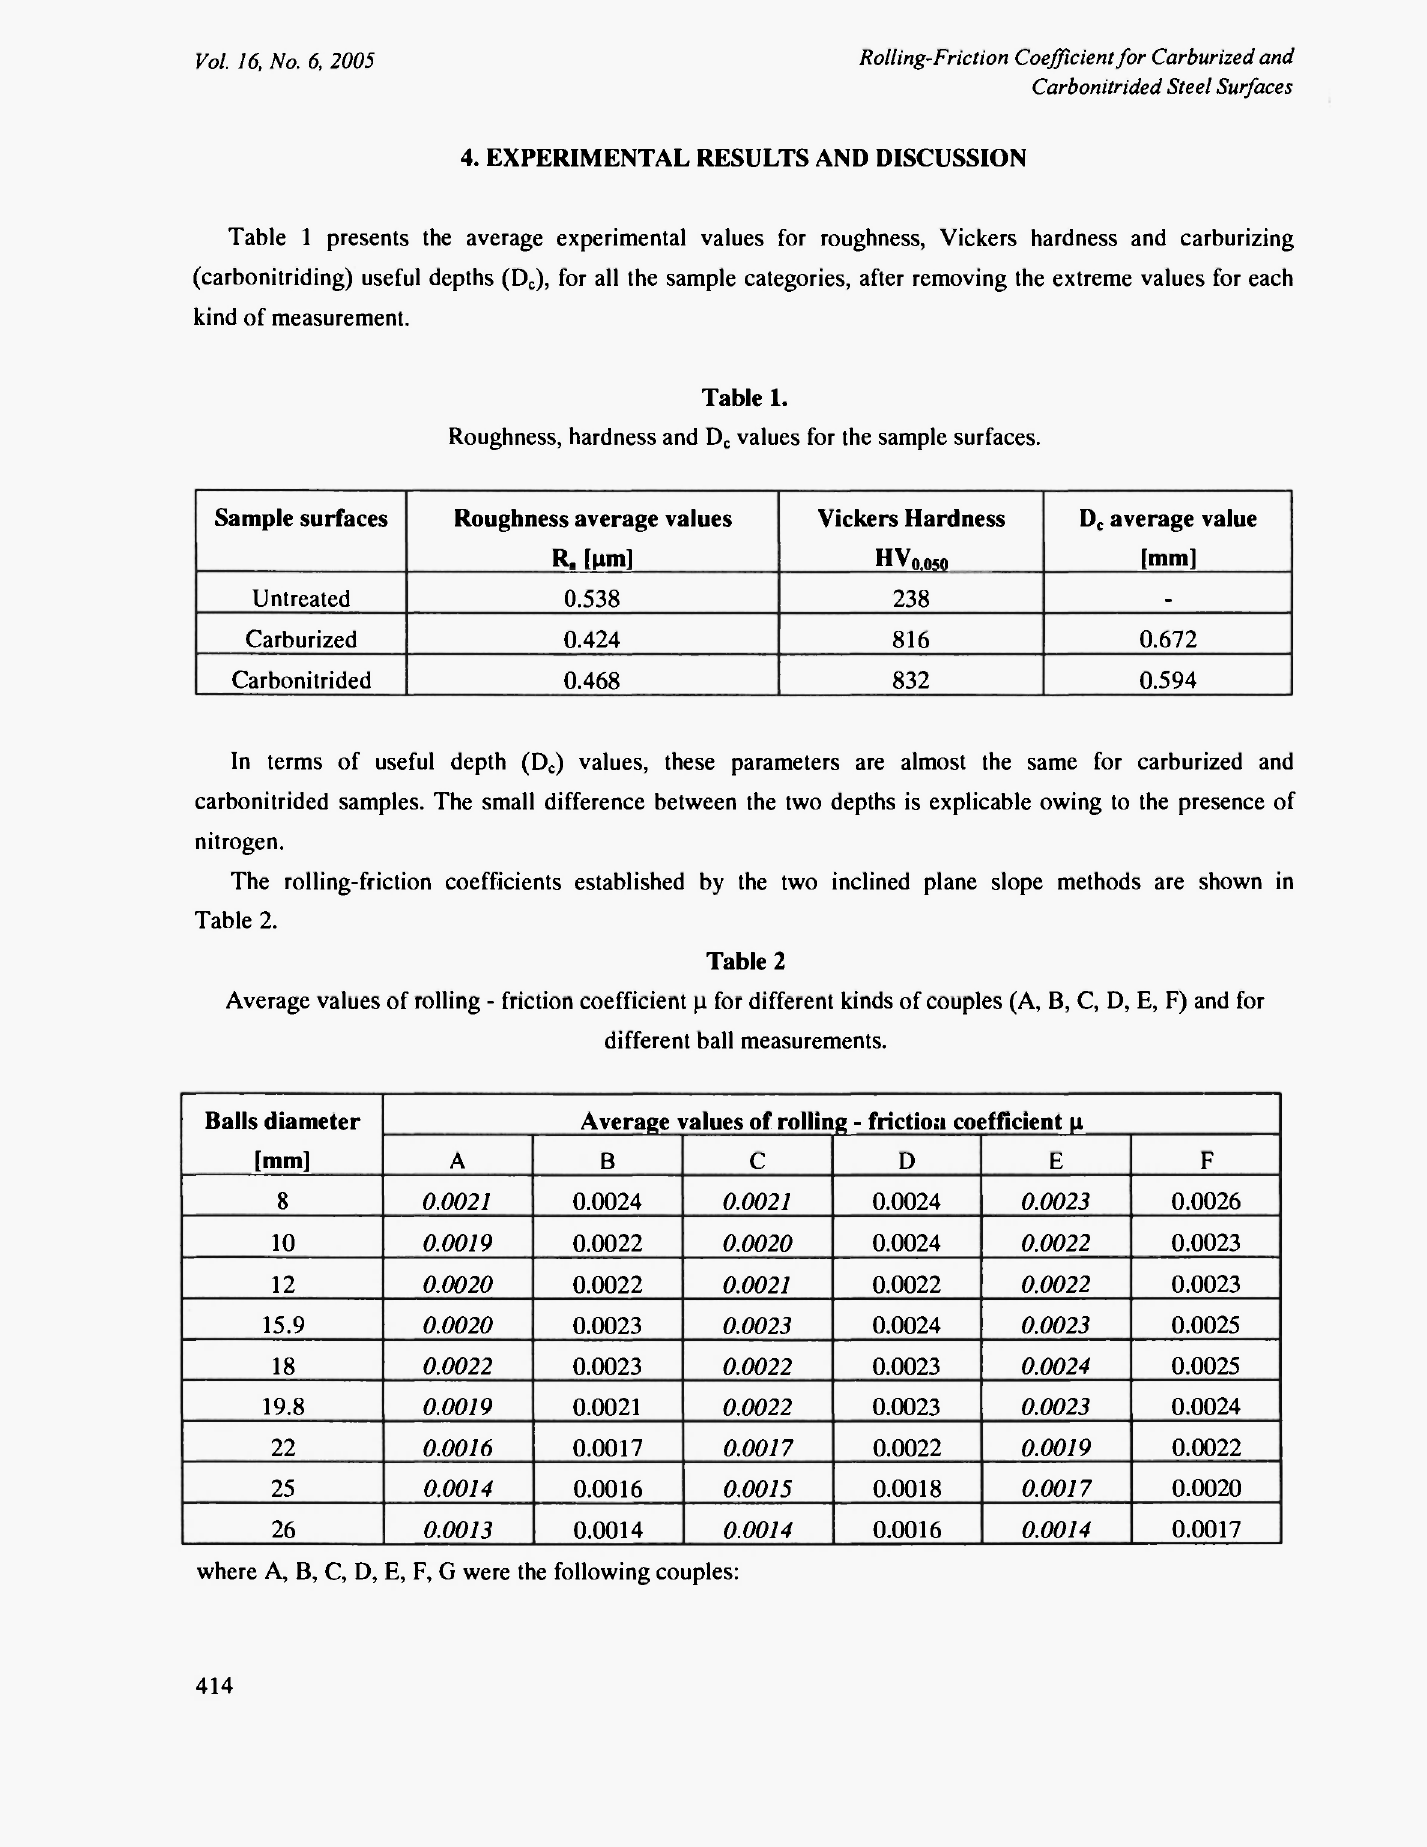
Average values of rolling - friction coefficient μ for different kinds of couples (A, B, C, D, E, F) and for different ball